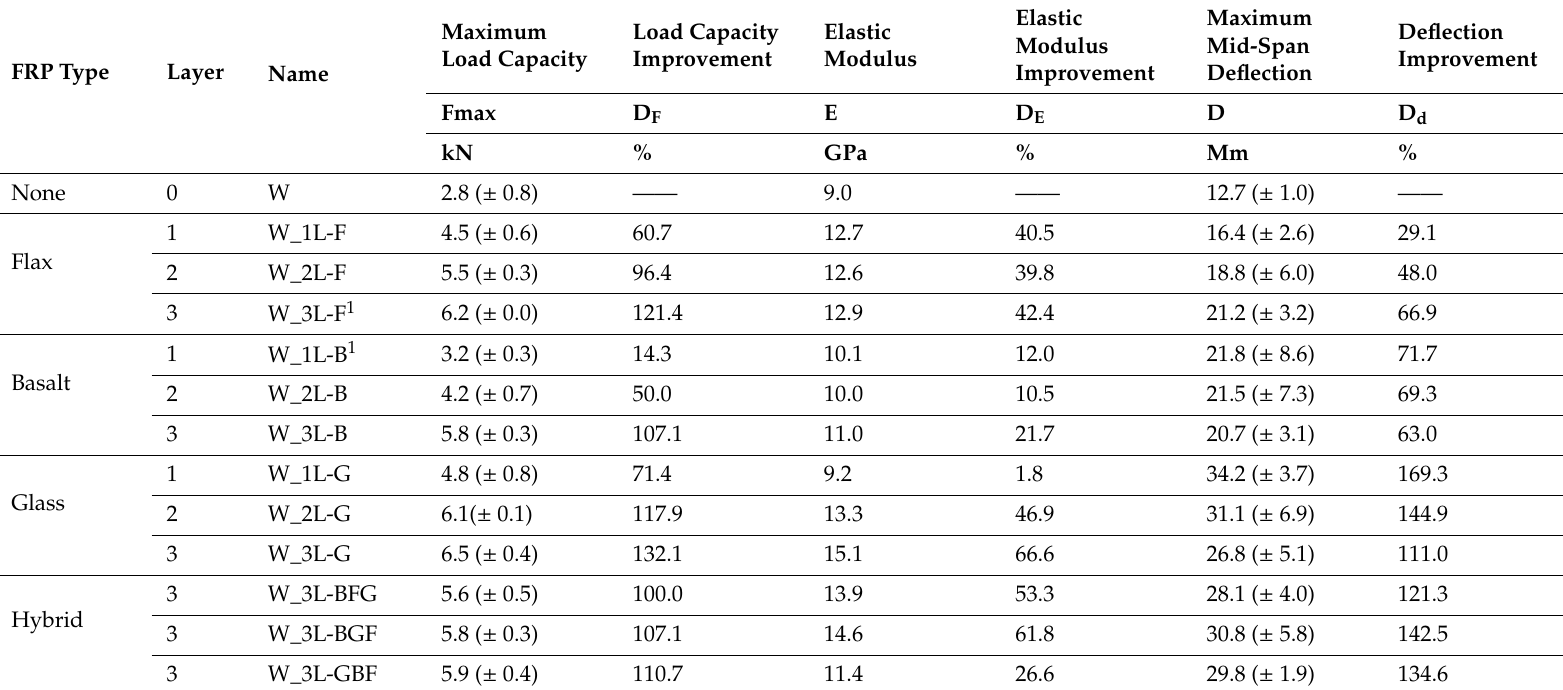
Table 3. Test results and relevant improvements of three-point bending test on wood